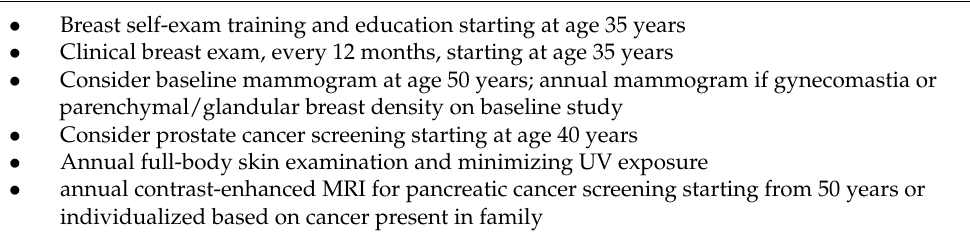
Table 2. Preventive strategies for the management of men at risk of hereditary breast cancer